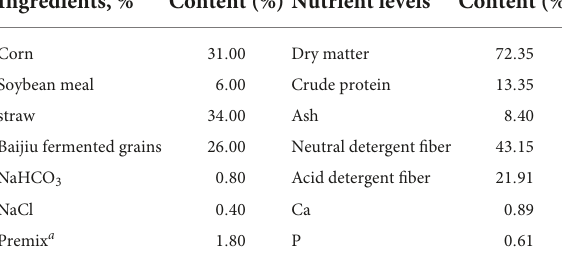
TABLE 1 Ingredients and nutrient levels of the experimental diets (dry matter